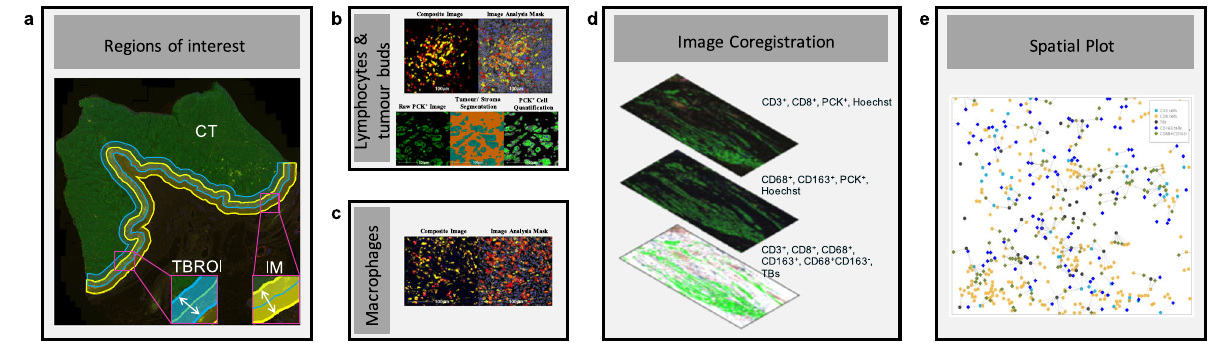
Fig. 2 Automated image analysis work fl ow. a Regions of interest for quanti fi cation of features. The tumor core is shown in green (CT), the tumor bud (TB) region of interest in blue (TBROI), and the invasive margin in yellow (IM). b Composite image: CD3 + cells in yellow and CD8 + cells in red, image analysis mask: classi fi cation of lymphocytes, CD3 + cells in yellow, CD8 + cells in red and their colocalization (CD3 + CD8 + ), based on image analysis thresholds, in orange, raw PCK + image: pancytokeratin + (PCK + ) cells (epithelial cells) in green, tumor/stroma segmentation: tumor regions in turquoise and stroma regions in orange, PCK + cell quanti fi cation: epithelial cell quanti fi cation within the tumor areas. c Composite image: CD68 + cells in yellow and CD163 + cells in red, image analysis mask: classi fi cation of macrophages, CD68 + cells in yellow, CD163 + cells in red and their colocalization in orange. d automatic image coregistration. e Spatial analysis for lymphocytes (CD3 + cells in light blue circles, CD8 + cells in orange circles), macrophages (CD68 + CD163 − cells in green rhombus and CD163 + cells in blue rhombus) and TBs (gray circles). Proximity lines are shown for macrophages within 50-µm of TBs or